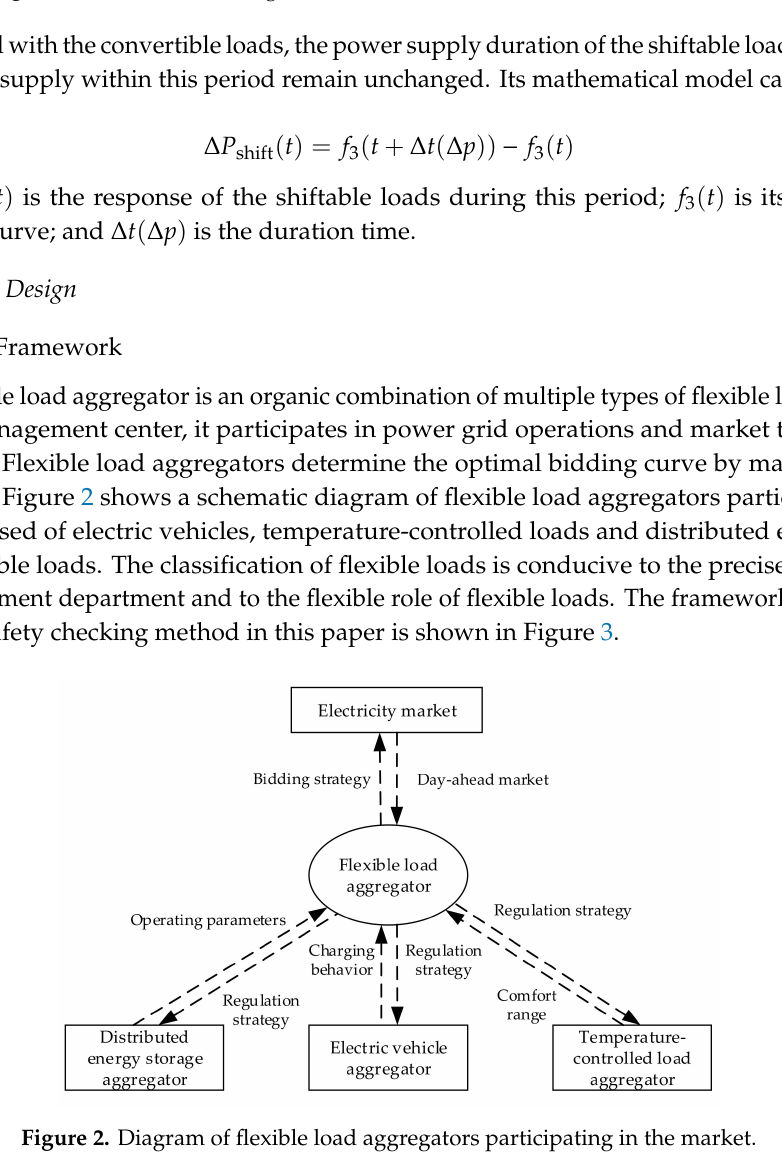
Figure 1. The schematic diagram of the transfer of three di ff erent shiftable loads.